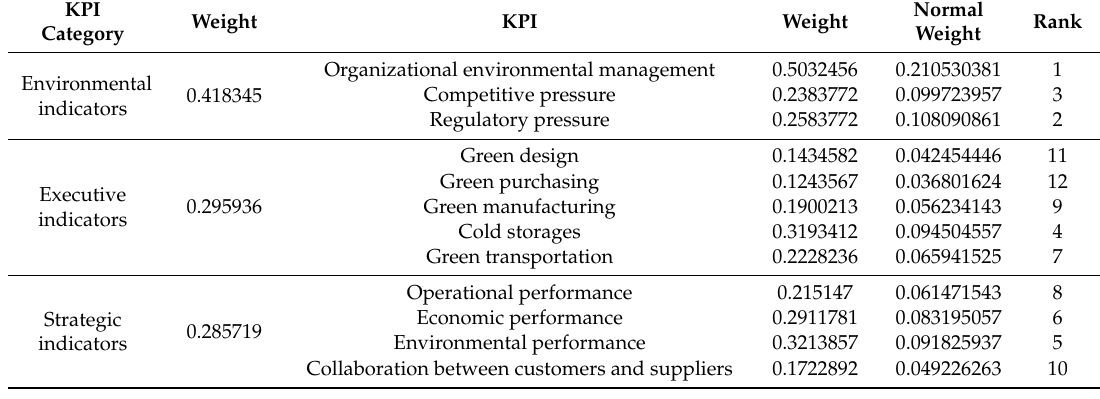
Table 17. Normalized weight and ranking of KPIs in the green supply chain (FMCG industries).